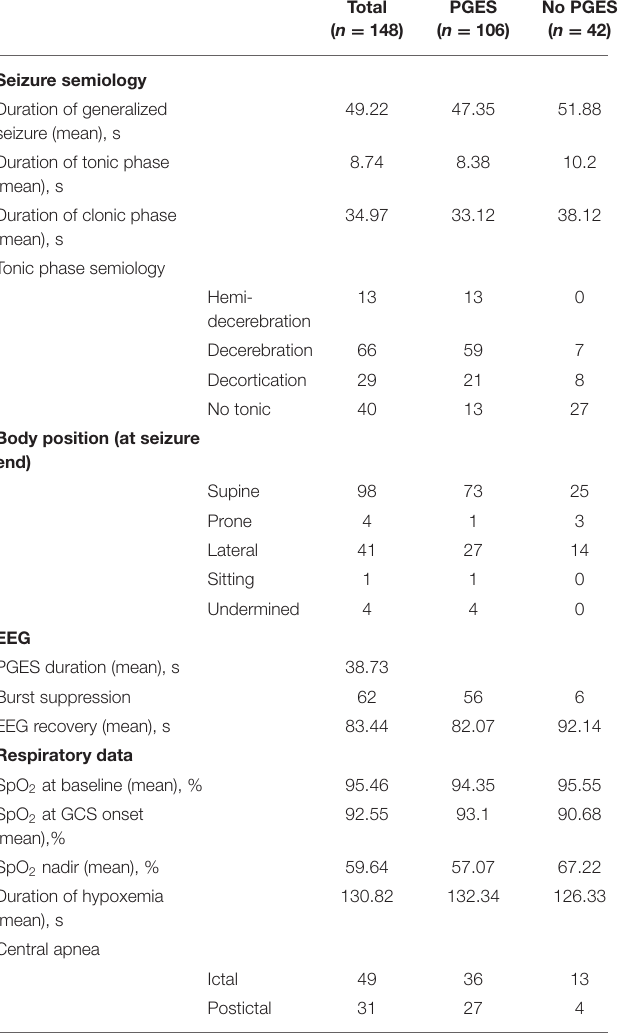
GCS, generalized convulsive seizure; BMI, body mass index. Bold value indicates the statistically significant (p <